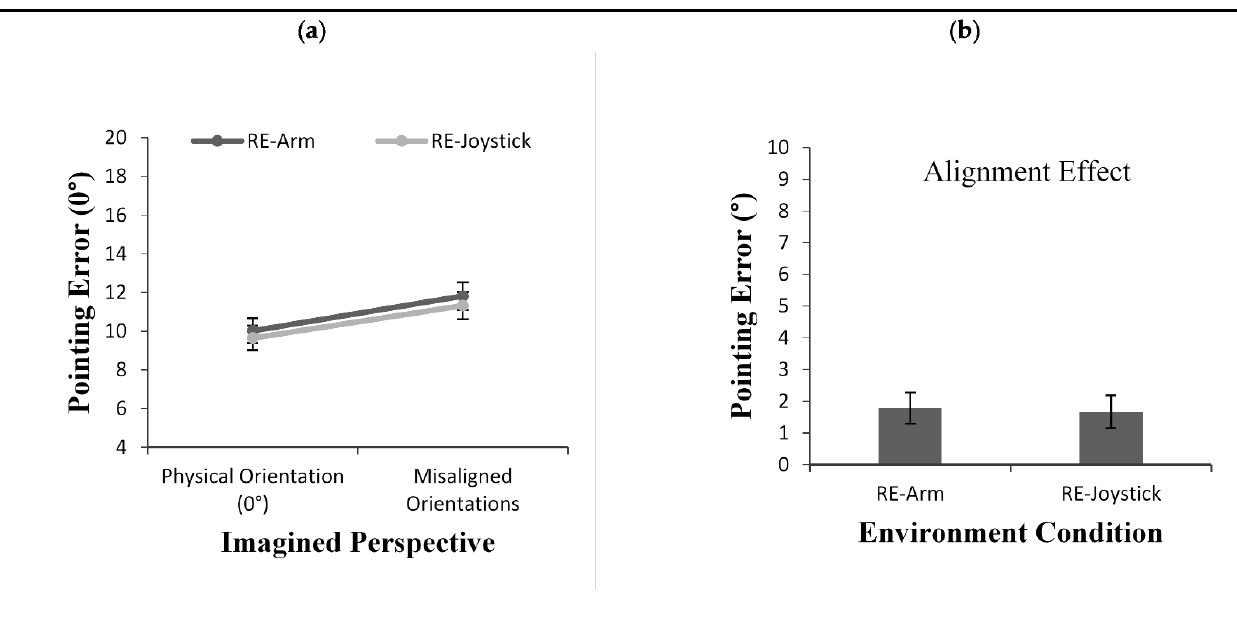
Figure 8. Pointing error ( a ) as a function of imagined perspective and alignment effect for pointing error ( b ) across test conditions (RE-Arm vs. RE-oystick) in Experiment 2 and Experiment 3. Error bars represent standard errors from the ANOVA and from a t -test, respectively.